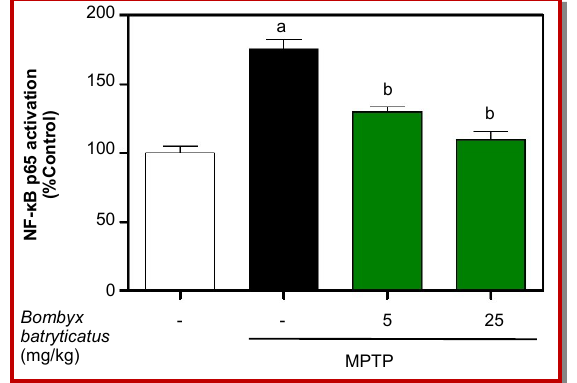
Figure 4: Effect of B. batryticatus on MPTP-induced NF- κ B p65 activation in SNpc of mice brain. Values are presented as mean ± standard error of the mean. a p<0.001 vs. control group; b p<0.001 vs. MPTP-treated group. MPTP, 1-methyl 4-phenyl 1,2,3,6-tetrahydropyridine; SNpc, substantia nigra pars com- pacta; NF- κ B, nuclear factor- κ B